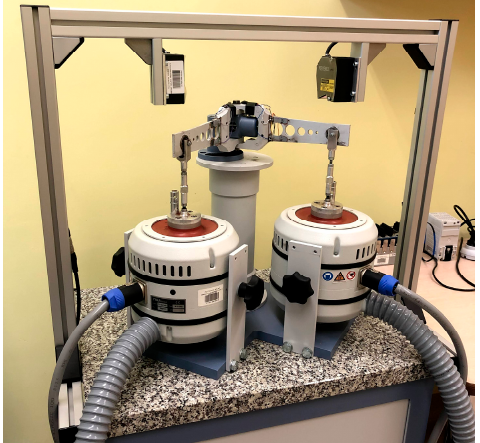
Figure 7. Testing system with a cylindrical specimen excited by two independent shakers.